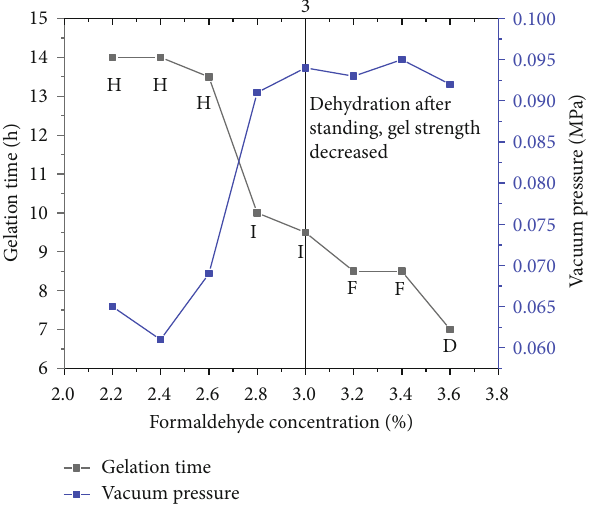
Figure 12: The e ff ect of formaldehyde cross-linking agent concentration on the gel formation and strength of the